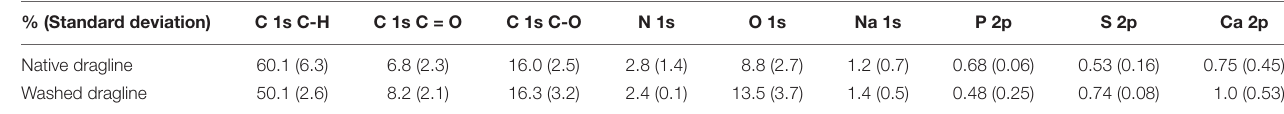
Numbers in parentheses are standard deviations in results obtained three different measurement